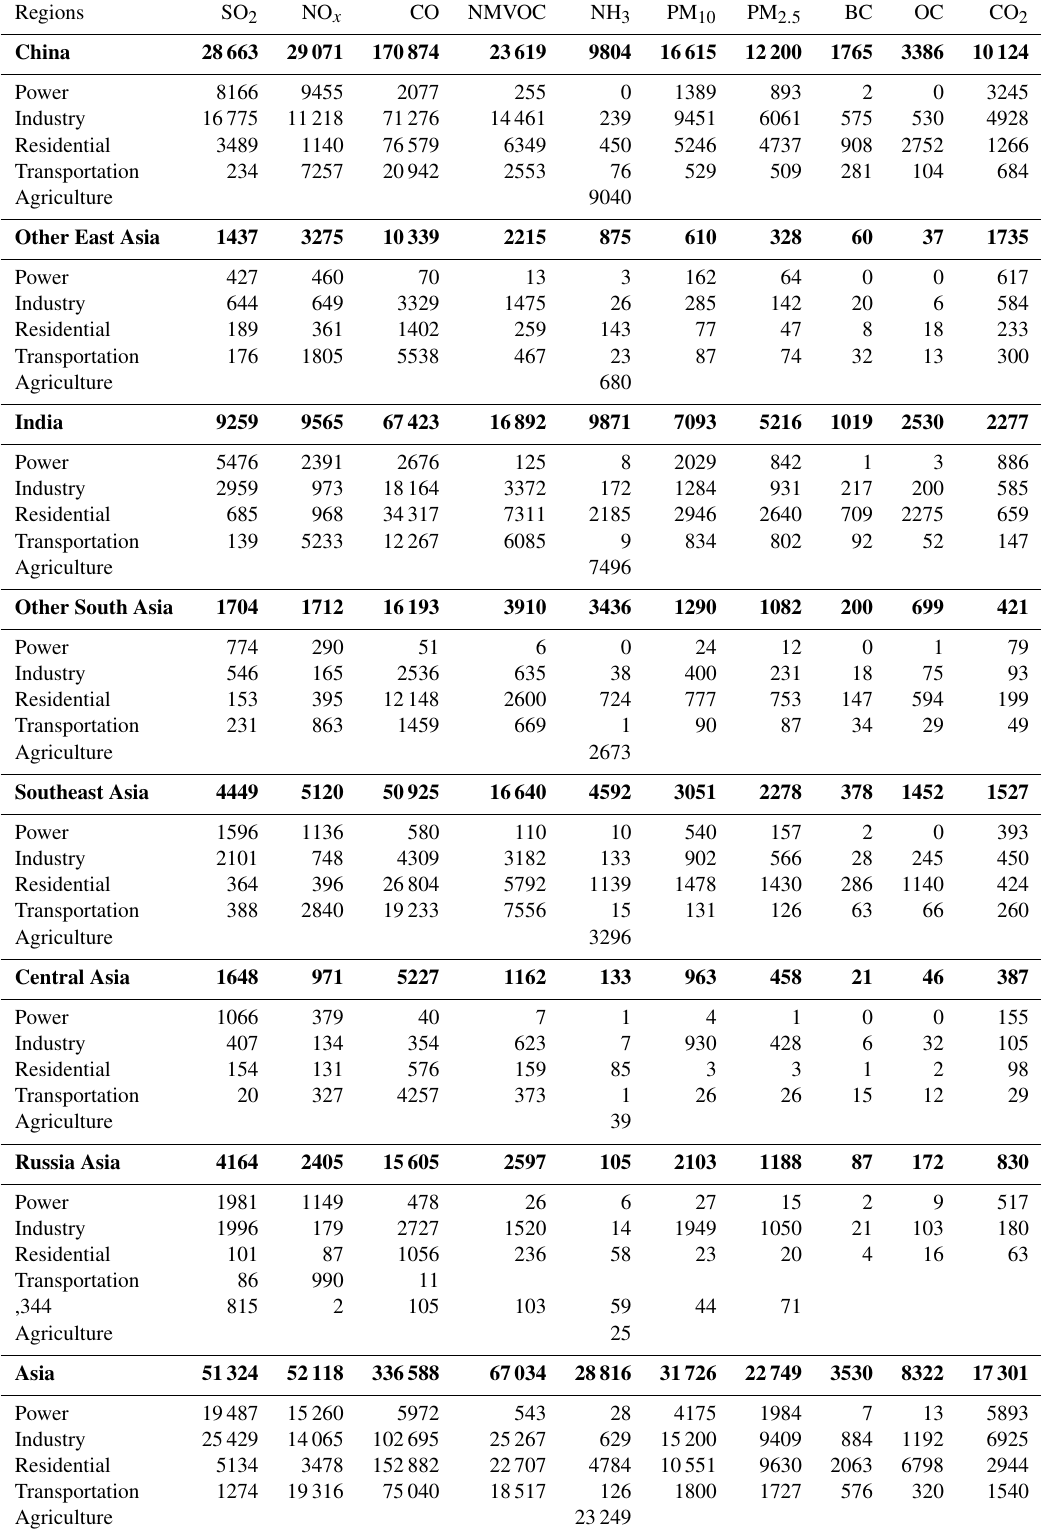
Table 4. Asian emissions by sector in 2010 for each region (units: Tg for CO 2 and Gg for other species). Bold values are the total emissions for Asian